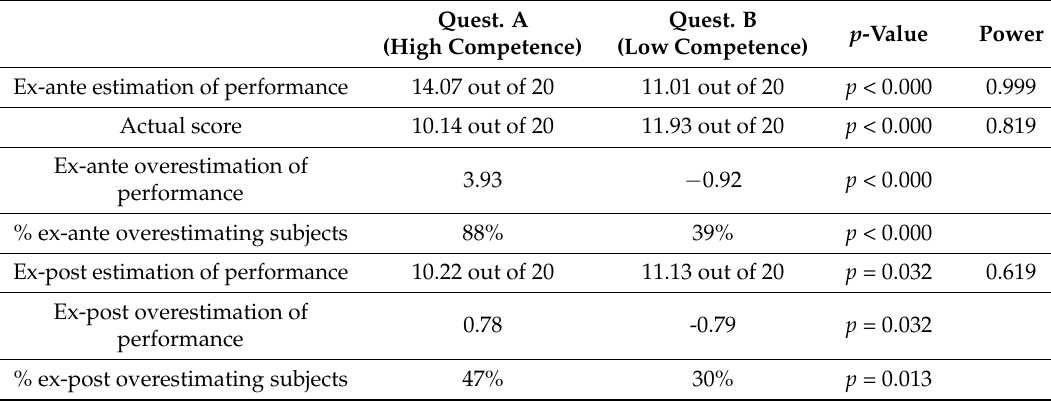
Table 1. The estimation and perceived competence in the Self Selection treatment